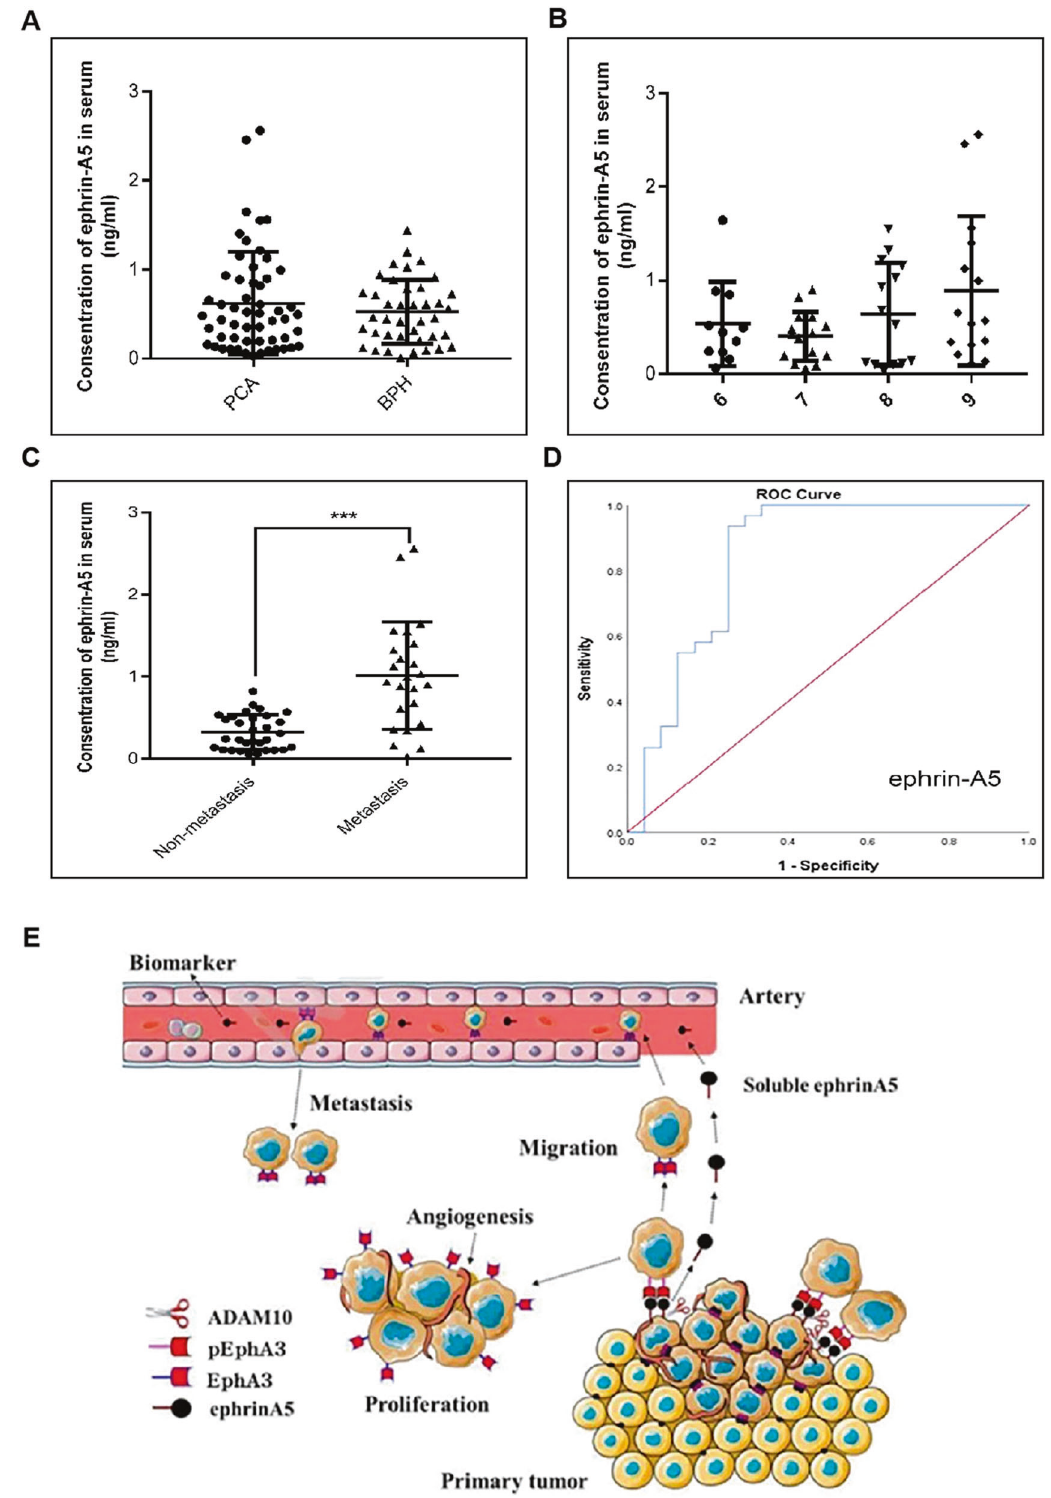
Fig. 7 Detection of serum ephrin-A5 by ELISA. A Serum ephrin-A5 levels were measured by ELISA in patients with prostate cancer ( n = 55) and benign prostatic hyperplasia ( n = 40), PCA vs BPH, P > 0.05. B The content of ephrin-A5 in serum of patients with different Gleason score. C Serum ephrin-A5 levels were detected by ELISA in patients with metastatic prostate cancer ( n = 24) and non-metastatic prostate cancer ( n = 31), Non-metastasis vs Metastasis, *** P < 0.001. D Evaluation of Serum ephrin-A5 as a Metastasis Marker of Prostate Cancer by ROC. E A schematic representation of prostate cancer metastasis caused by ADAM10 and EphA3/ephrin-A5 complex.